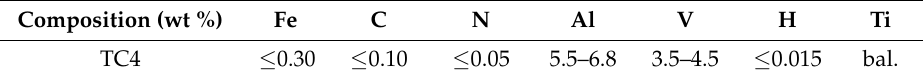
Figure 1. Microstructure of TC4 alloy. Table 1. Chemical composition of TC4 alloy.